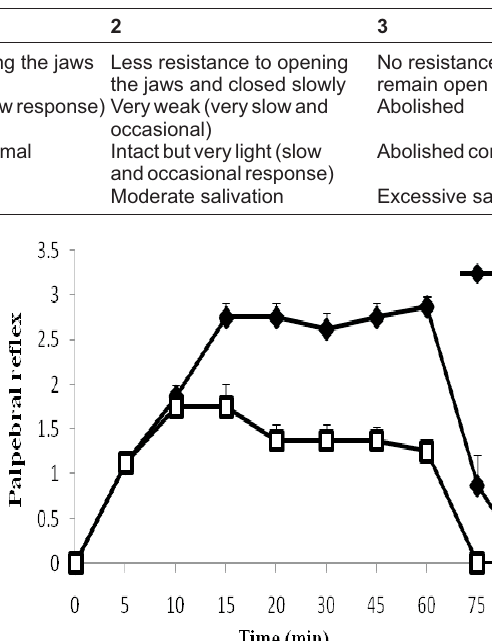
Table-1: Numeric scoring system used for recording of various reflexes and responses. Clinical parameter